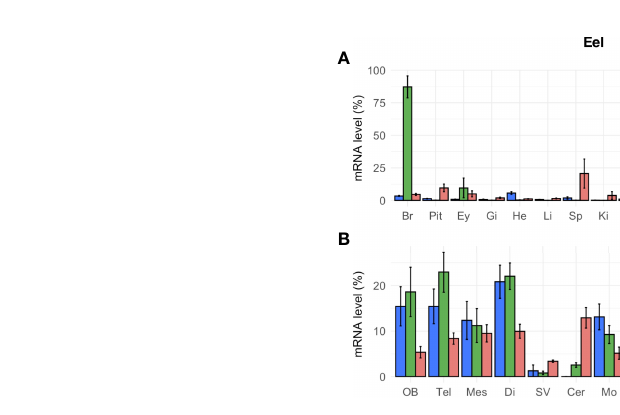
FIGURE 6 | Tissue distribution of crh paralogs in silver female European eels as measured by qPCR. (A) crh1a, crh1b and crh2 expression in the brain (Br), pituitary (Pit), eyes (Ey), and various peripheral organs, gills (Gi), heart (He), liver (Li), spleen (Sp), kidney (Ki), intestine (Int), fat (Fat), muscle (Mu), skin (Sk) and gonad (Go). (B) crh1a , crh1b and crh2 expression in various brain regions: olfactory bulb (OB), telencephalon (Tel), mesencephalon (Mes), diencephalon (Di), saccus vasculosus (SV), cerebellum (Cer), medulla oblongata (Mo), optic tectum (OT), epiphysis (Ep), pituitary (Pit) and retina (Ret). Results (means ± SEM; n=9-10) are presented as percentage per tissue.